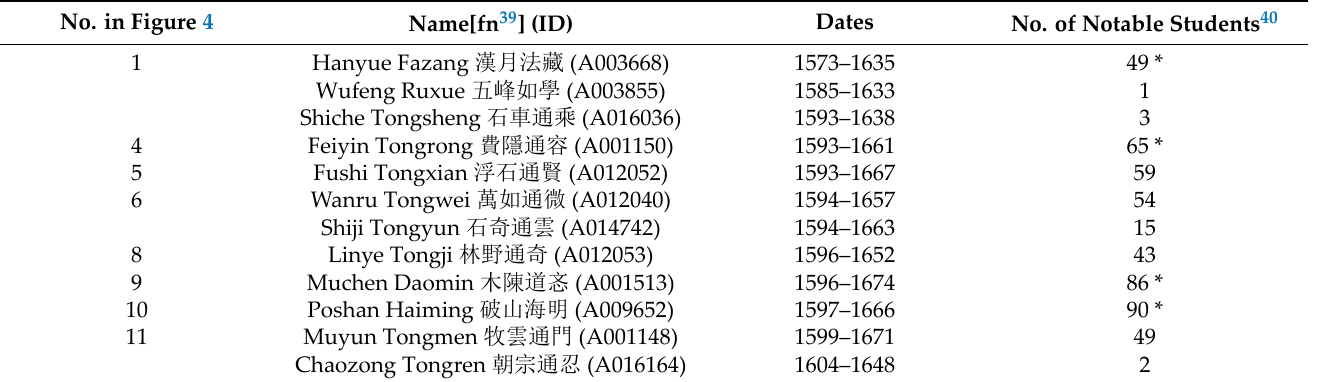
Table 1. Miyun’s twelve dharma heirs (marked with a * are the four branches the Tiantong Temple website considers most successful 38